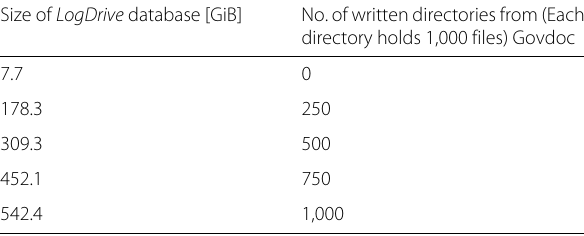
Table 5 Size of the LogDrive databases for the